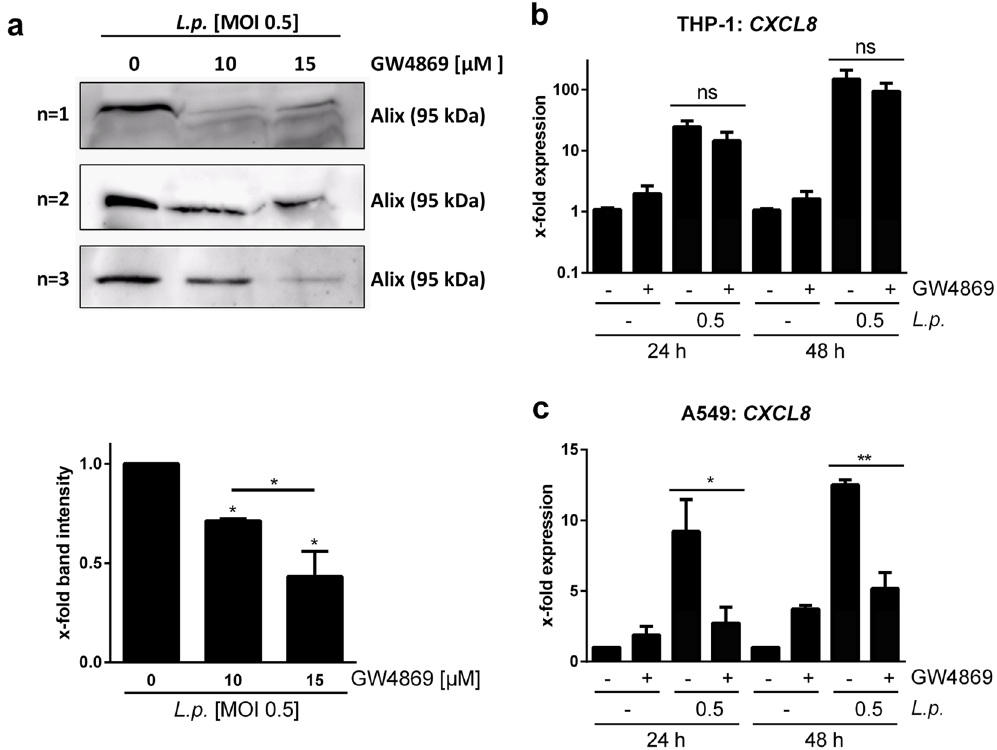
Figure 5. Block of exosome release does not reduce the THP-1 response to the 100 k pellet. ( a ) THP-1 cells were incubated with GW4869 (10 or 15 µ M) or DMSO as a solvent control for 1 h before infection with L . pneumophila (MOI 0.5) for 24 h. A 100 k pellet was generated and Alix expression was analysed by western blot. Densitometric quantification of western blot bands is shown. Exosome secretion is reduced after GW4869 treatment. ( b , c ) Donor THP-1 cells were pre-incubated with GW4869 (15 µ M) or the solvent control for 1 h before infection with L . pneumophila for 24 h. EVs were purified by differential centrifugation and added to THP-1 ( b ) or A549 ( c ) cells. CXCL8 expression was analysed by qPCR after 24 or 48 h of incubation. Data are shown as mean + SEM of three independent experiments. * p < 0.05, ** p < 0.01, ns: not